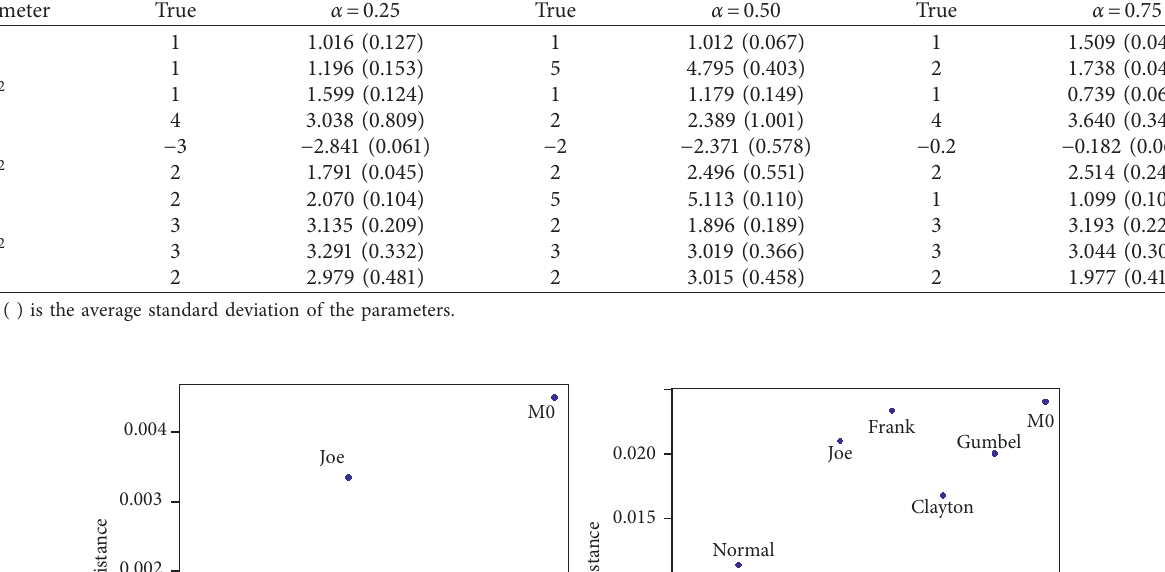
Table 3: Mean and standard deviation of the Bayesian estimate of the Frank copula at three quantile levels. Parameter